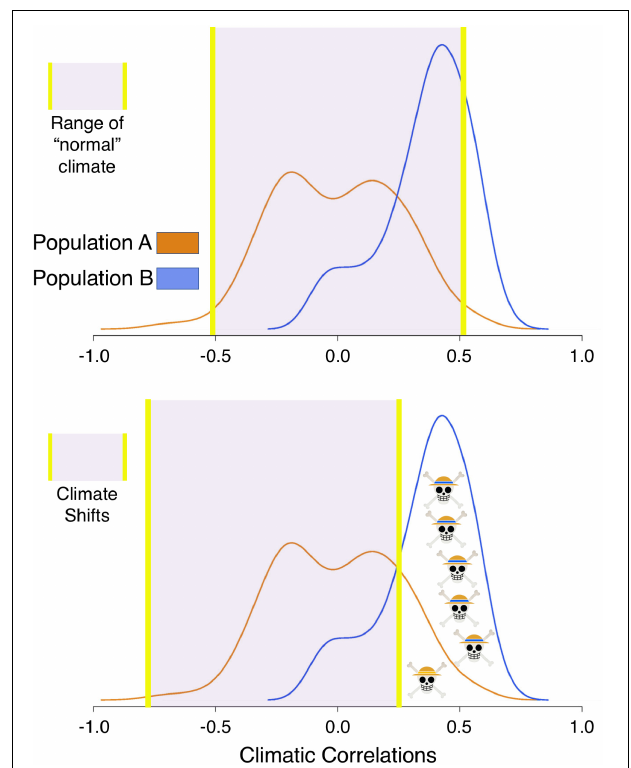
FIGURE 1 | Population vulnerability Framework. In the first scenario (top panel) the climate is within a range suitable for the growth of most trees in Population A (orange, centered around zero) and Population B (blue, positively skewed). Using tree-level correlations to minimum temperatures as an example, the distribution of correlations indicates that in Population B, warming would enhance growth. In the second scenario (bottom panel), climate cools, making Population B, where more individuals correlate positively with temperature, more vulnerable to this particular shift in climate. See text to see how the framework is